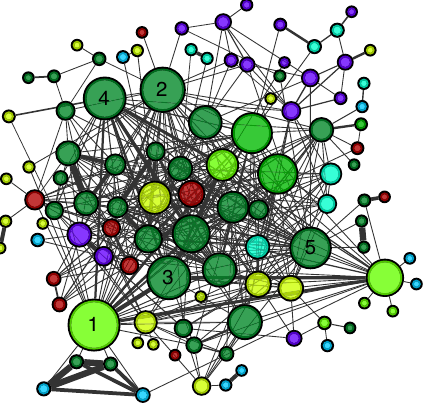
Figure 4. Network community ‘E’ characterized by immune-related disorders. Focused subgraph of community E from the Phenotypic Network. The most connected diseases in the community are Crohn’s disease ( 1 ), rheumatoid arthritis ( 2 ), ulcerative colitis ( 3 ), psoriasis ( 4 ), and lupus ( 5 ).